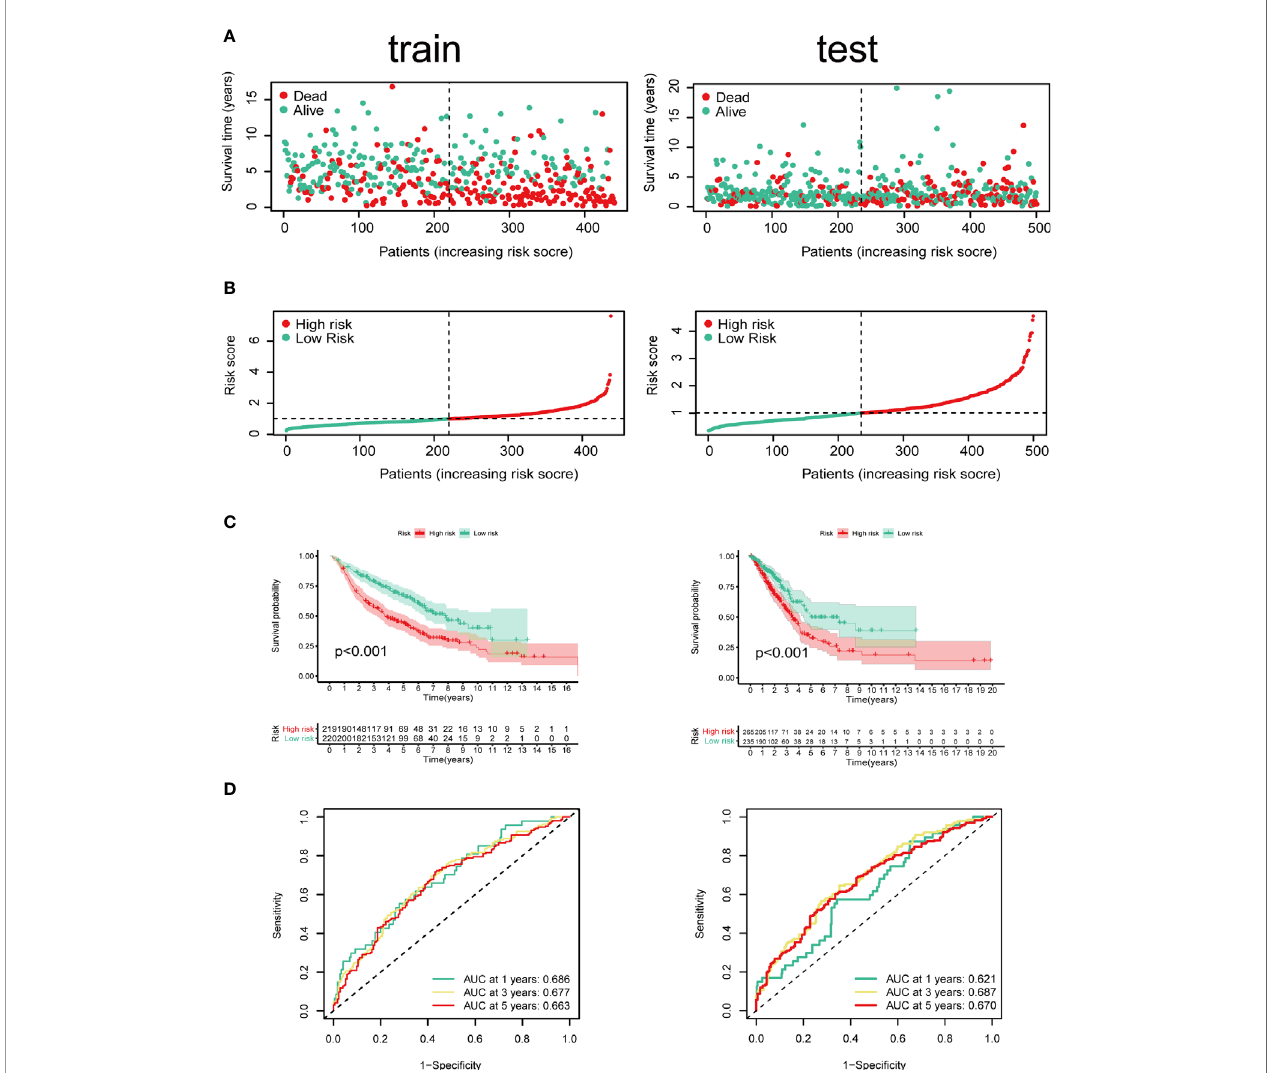
FIGURE 4 | Identi fi cation of prognostic model in train set and test set based on OS of LUAD in GEO and TCGA cohorts. (A) The survival status and survival time of patients with LUAD ranked by risk score. (B) Rank of risk score and distribution of groups. Patients with LUAD were divided into high- and low-risk groups based on the median value of the risk score calculated. (C) Kaplan-Meier analysis and (D) time-dependent ROC curve of risk